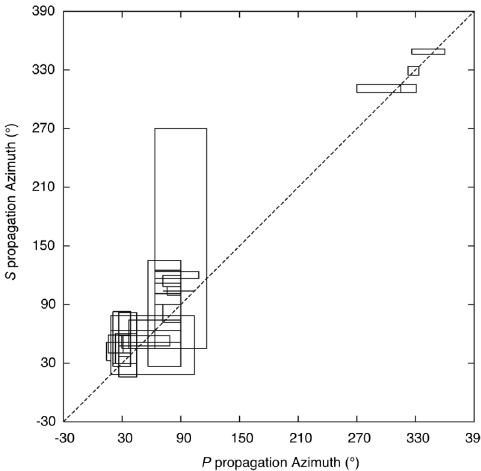
Fig. 13. Comparison of the propagation azimuths derived from slowness analyses of P- and S- waves. Width and height of the boxes correspond to the un- certainty on slowness estimates.